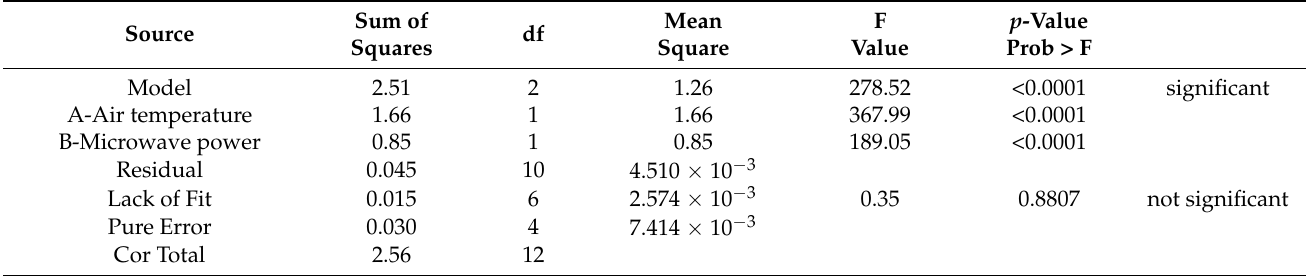
Table 6. Analysis of variance for drying time response using RSM.